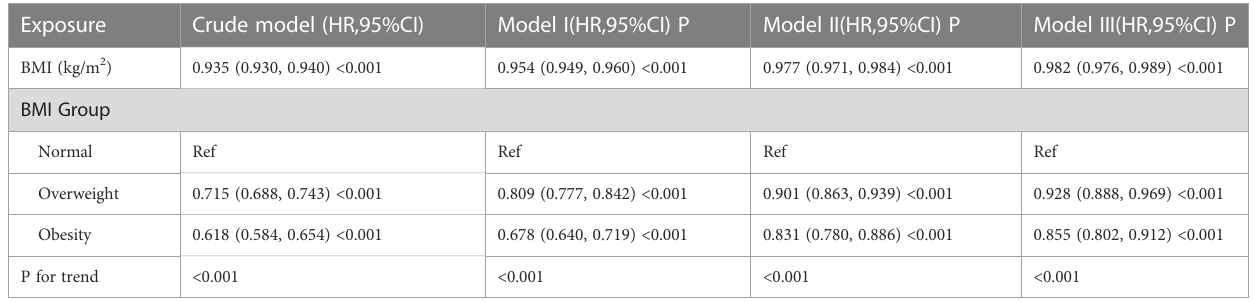
TABLE 4 Relationship between BMI and reversion to normoglycemia in patients with IFG in different models.